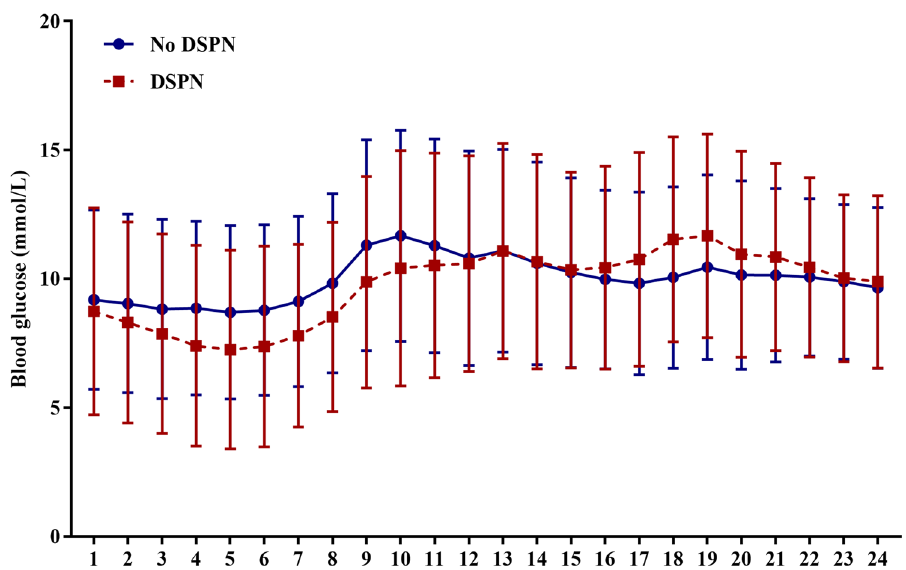
Figure 1. Comparison of hourly glucose concentrations between subjects with and without